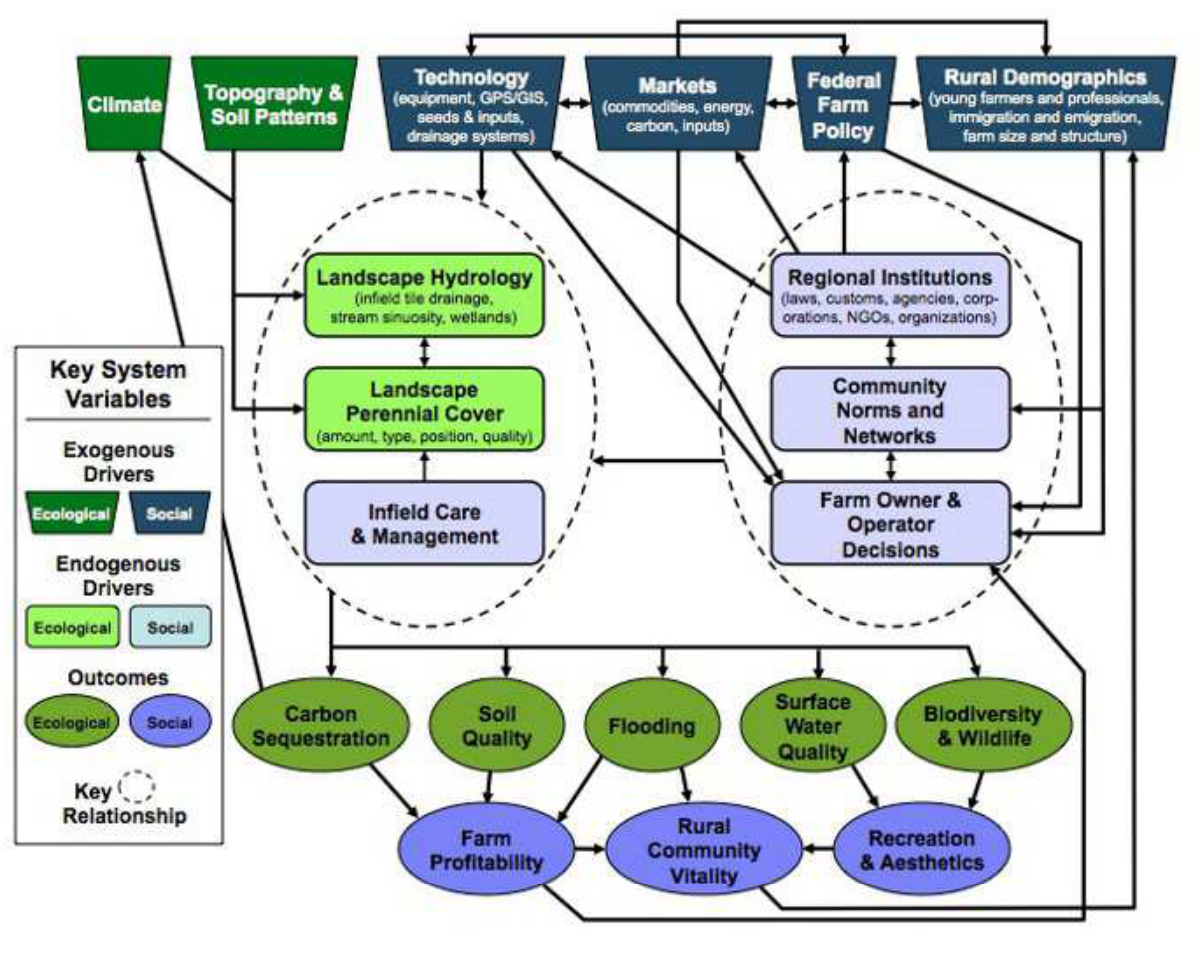
Fig. 3. Analysis of workshop data and the results of other regional studies highlighted key drivers and focal relationships influencing land use in Iowa’s agricultural landscapes (Table 2). Exogenous system drivers are macroscale influences on the system that set the range of possible futures. Endogenous drivers are regionally controlled system components that vary across potential futures to influence the patterns and processes of future landscapes. Exogenous and endogenous drivers combine to influence multiple ecosystem services and societal goods, all of which were seen as important outcomes of rural